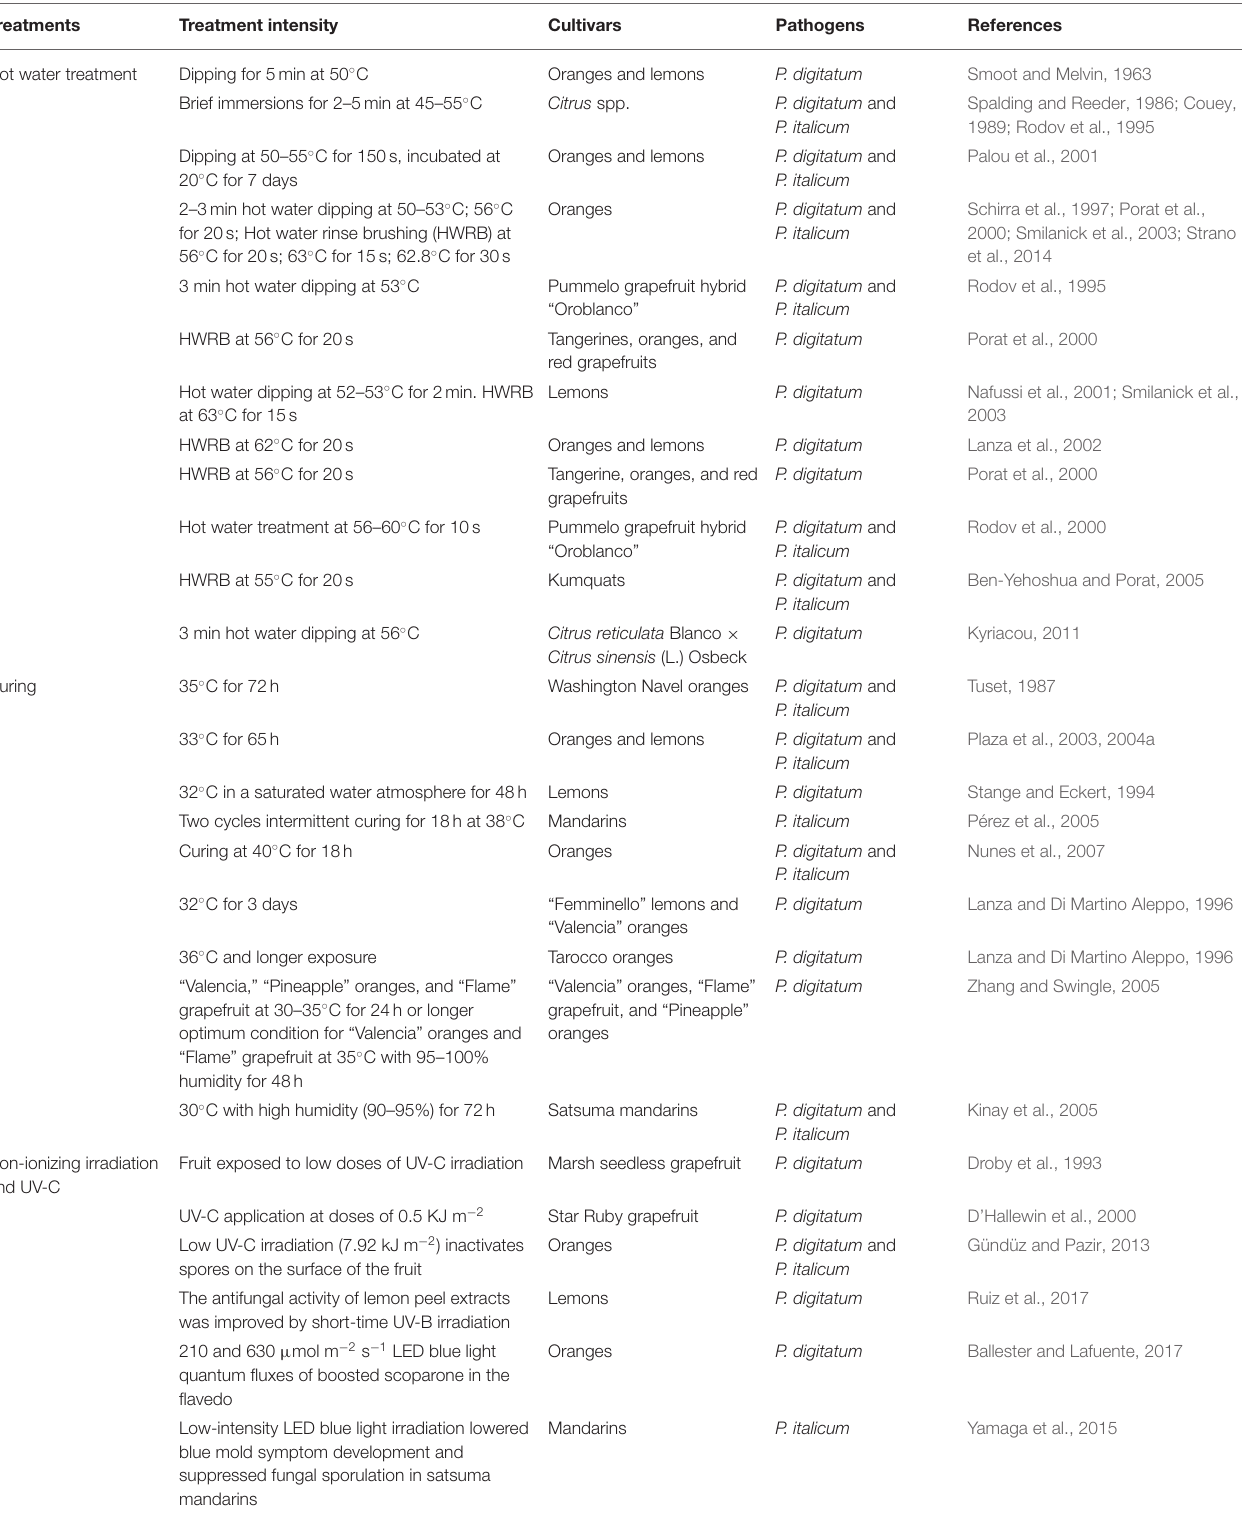
TABLE 4 | Physical methods for the control of P. digitatum and P. italicum